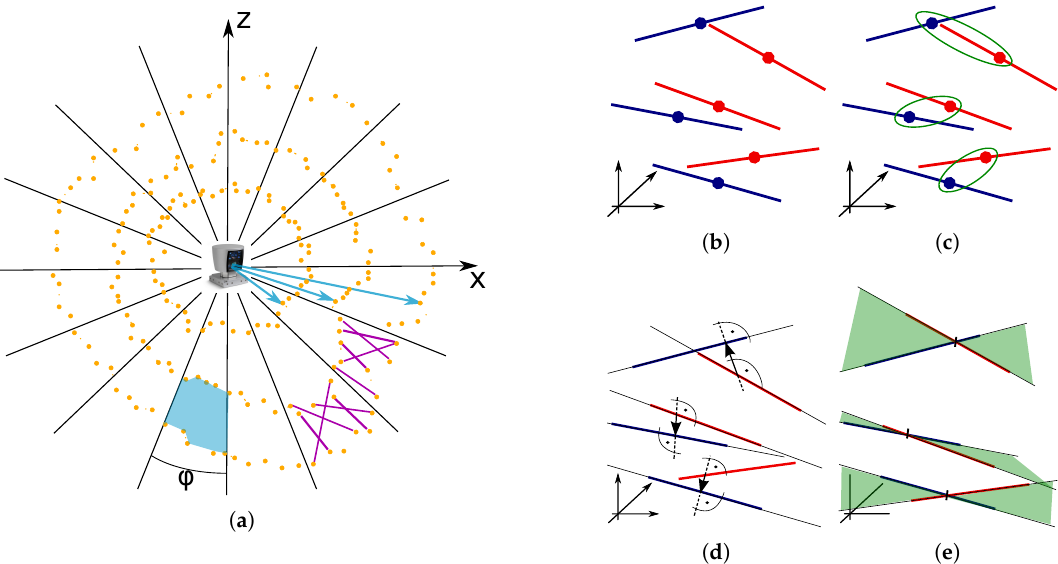
Figure 11. The sampling of Velodyne point cloud by the Collar Line Segments (CLS) ( a ). The segments (purple) are randomly generated within the polar bin (blue polygon) of azimuthal resolution φ . The registration process ( b – e ) transforms the line segments of the target point cloud (red lines) to fit the lines of the source cloud (blue). First, the lines are matched by Euclidean distance of midpoints ( c ); then, the segments are extended into infinite lines and the vectors between closest points are found ( d ); and, finally, they are used to estimate the transformation that fits the matching lines into common planes (green in ( e